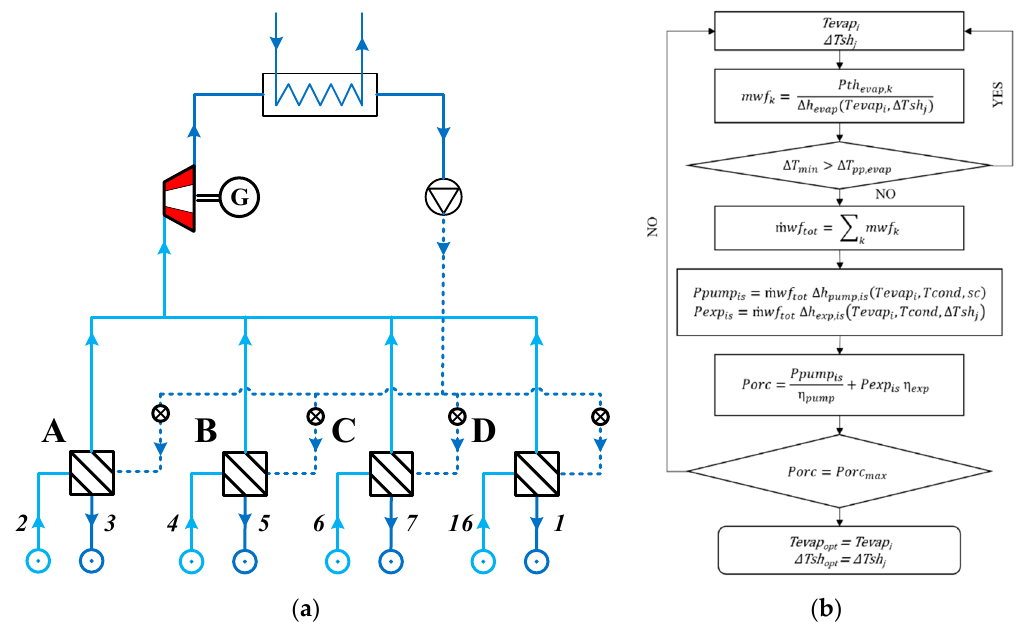
Figure 3. LT–ORC layout ( a ) and optimization algorithm flowchart ( b ).